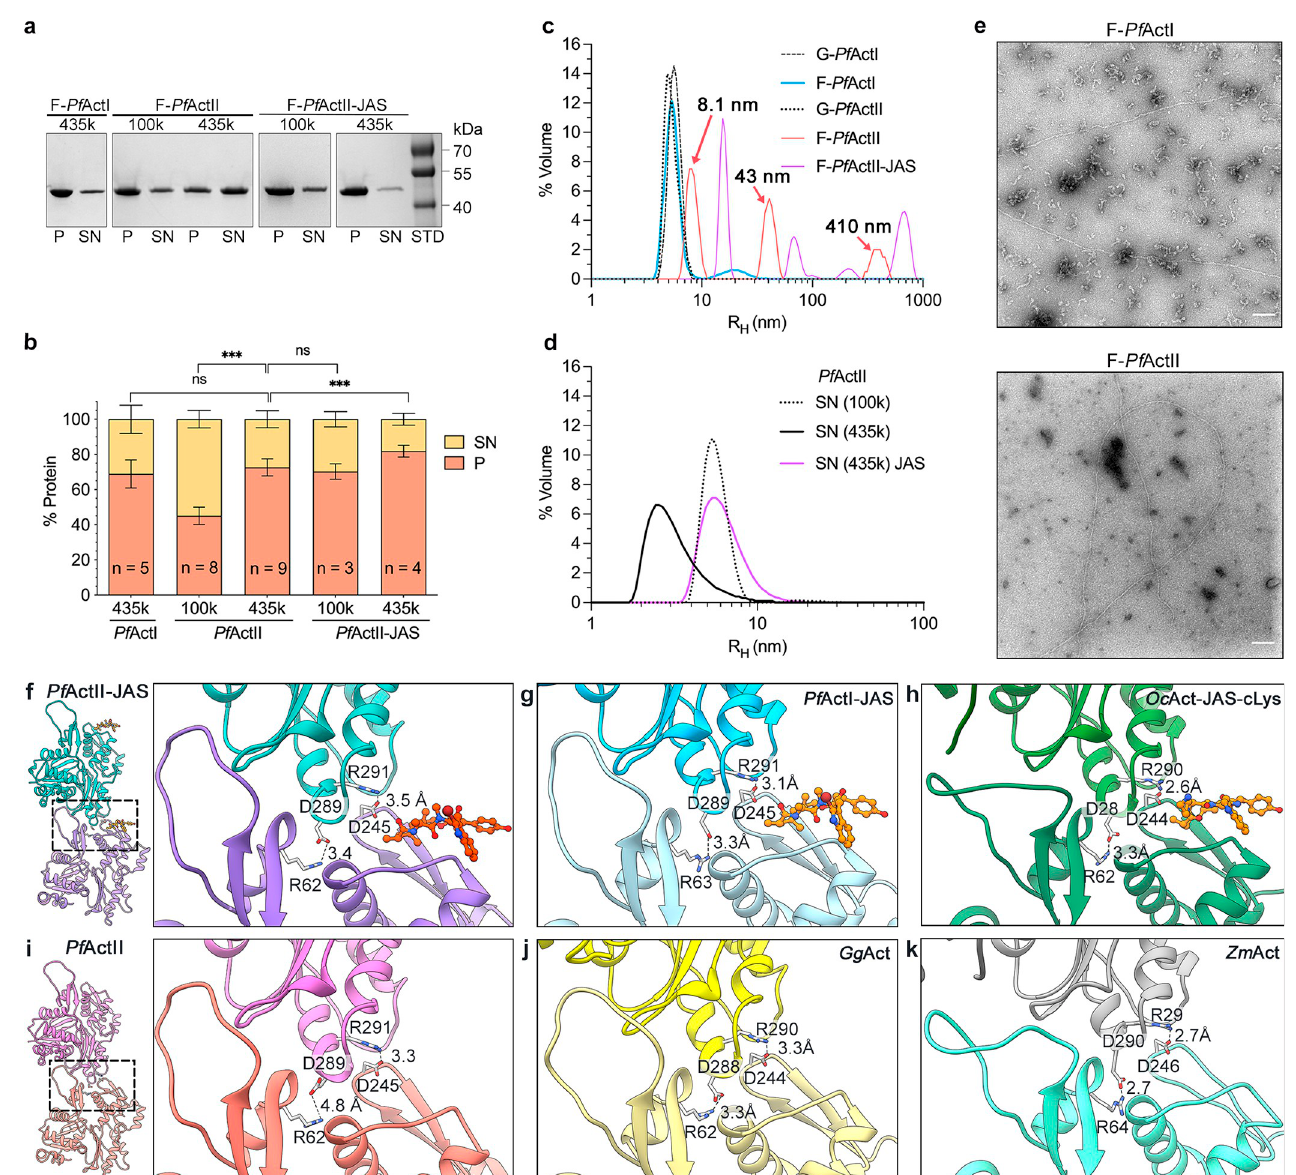
Fig 7. Polymerized Plasmodium actins. (a). SDS-PAGE of a standard sedimentation assay of actin I and actin II, where the pellet (P), and supernatant (SN) fractions have been separated by ultracentrifugation at 4˚C for 1 h. (b). Quantification of the sedimentation assays expressed as the percentage of protein in each fraction after ultracentrifugation at 100000 or 435000 g . The samples were polymerized in the presence or absence of JAS in a ratio of 1:1. (c-d) DLS profile of Plasmodium actins.The 8.1, 43, and 410 nm peaks in the F- Pf ActII sample (panel c, red curve) are indicated with arrows. (e). EM micrographs of polymerized Actin I (1 μ M) and actin II (2 μ M). Scale bars represent 100 nm. (f-k) Salt bridge interactions between two adjacent protomers. Actin filaments in the presence of JAS (f) actin II, (g) actin I (6TU4), (h) α -actin (5OOC). Structures without JAS (i) actin II, (j) α -actin (6DJO), (k) Z . mays actin (6IUG). Distances are indicated with black dashed lines. The error bars represent the standard deviation, ��� < 0.001, � < 0.05, and ns: not significant, two-tailed Student’s t-test. Raw data related to panel b can be found in S3 Data and panels c and d in S4